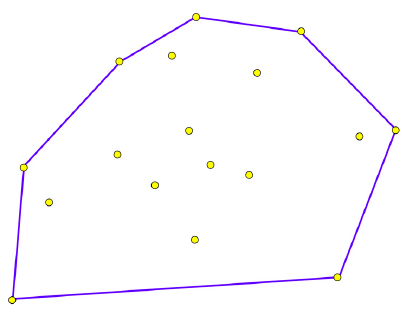
Figure 6. Two-dimensional (2D) convex hull structure for a given set of points.